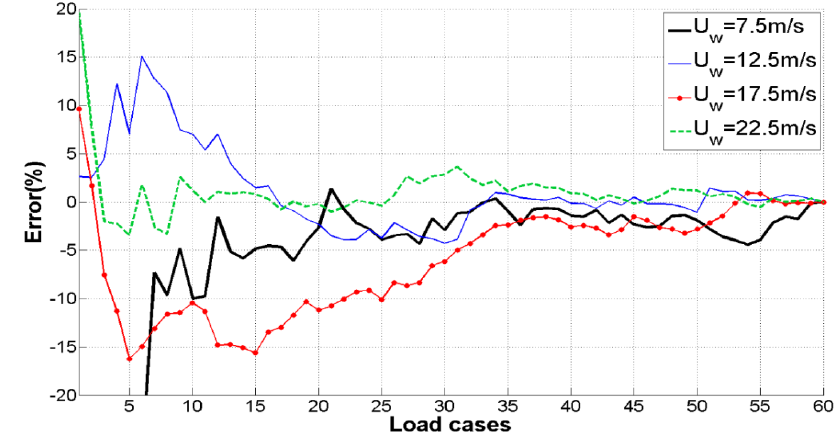
Figure 8. Simulation deviation (error) for the wind-load-alone cases. The graph indicates that the error curve converges as the number of simulations increases.